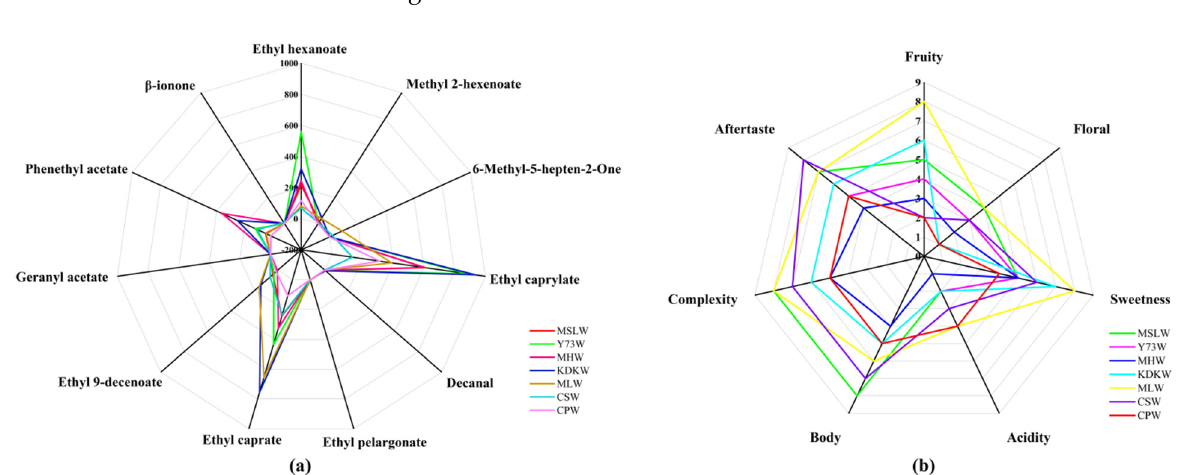
Figure 11. Eleven important aroma compounds (OAV > 1) in wines produced from seven different grape varieties ( a ). Sensory analysis of different wines ( b ). Samples’ full names, as follows: MSL (Marselan), Y73 (Yan 73), MH (Muscat Hamburg), KDK (Kadarka), ML (Merlot), CS (Cabernet Sauvignon) and CP (Crimpose). Furthermore, G represents “grape” and W represents “wine”.